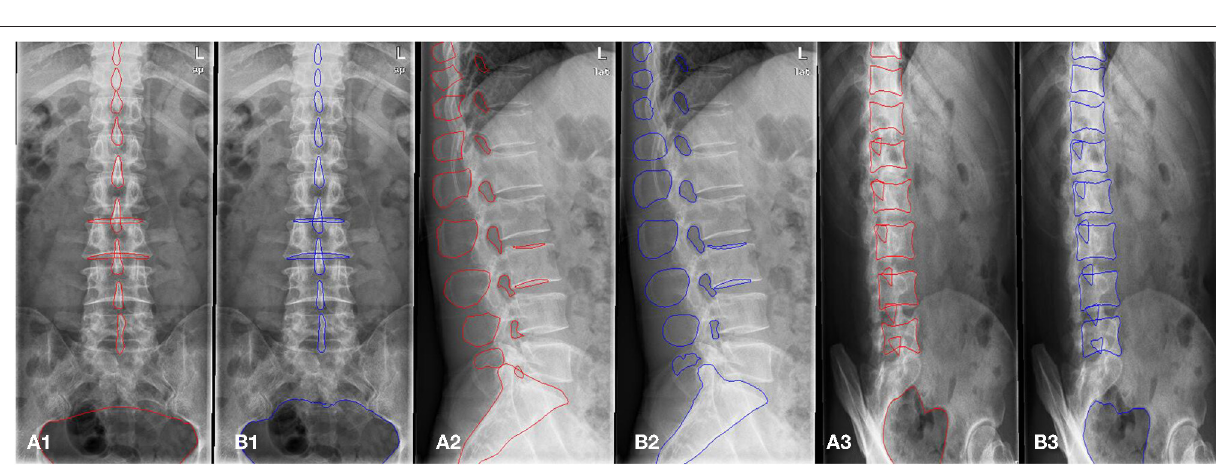
anteroposterior, lateral, and oblique. The first U-net was used